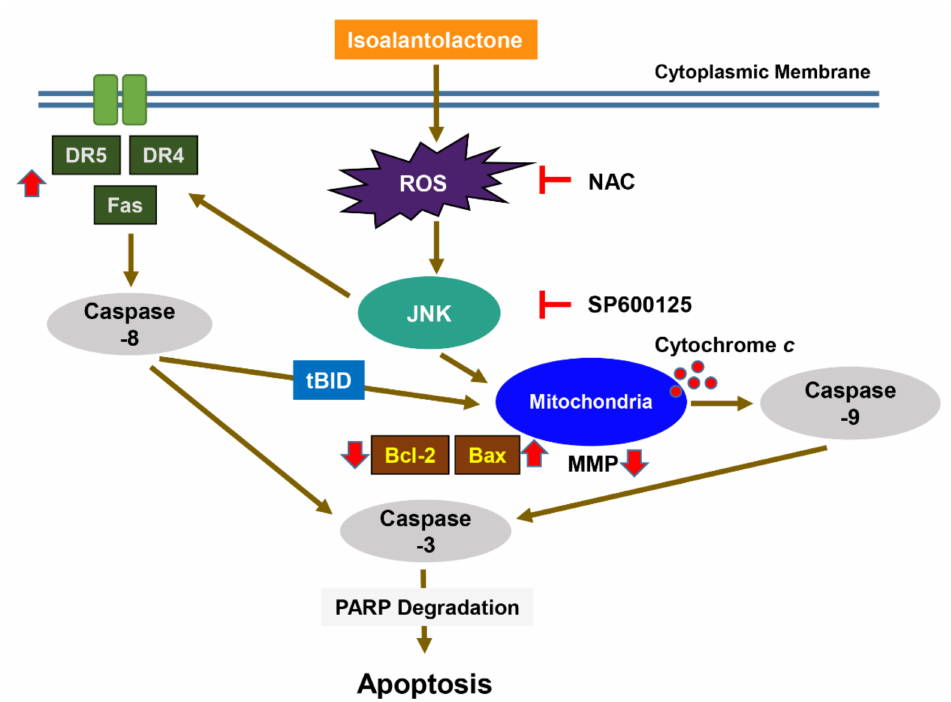
Figure 6. Graphical diagram denoting the mechanism of IALT-induced apoptosis in human HCC Hep3B cells. Exposure to IALT induces ROS-mediated activation of JNK and promotes the activation of extrinsic and intrinsic apoptosis pathways. Therefore, ROS act as upstream regulators of the JNK signaling pathway for apoptosis